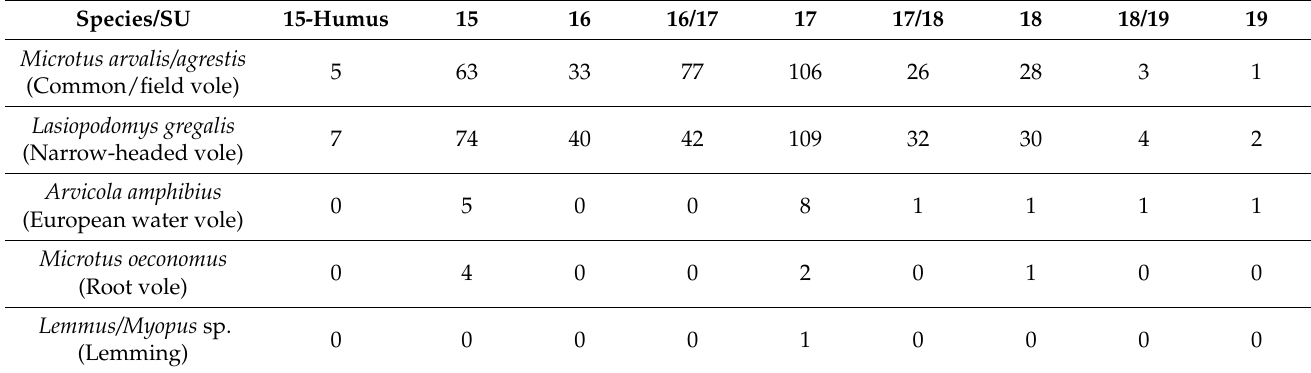
Table 1. Micromammal species diversity at La Roche- à -Pierrot for each stratigraphic unit (SU), expressed in MNI (Minimum Number of